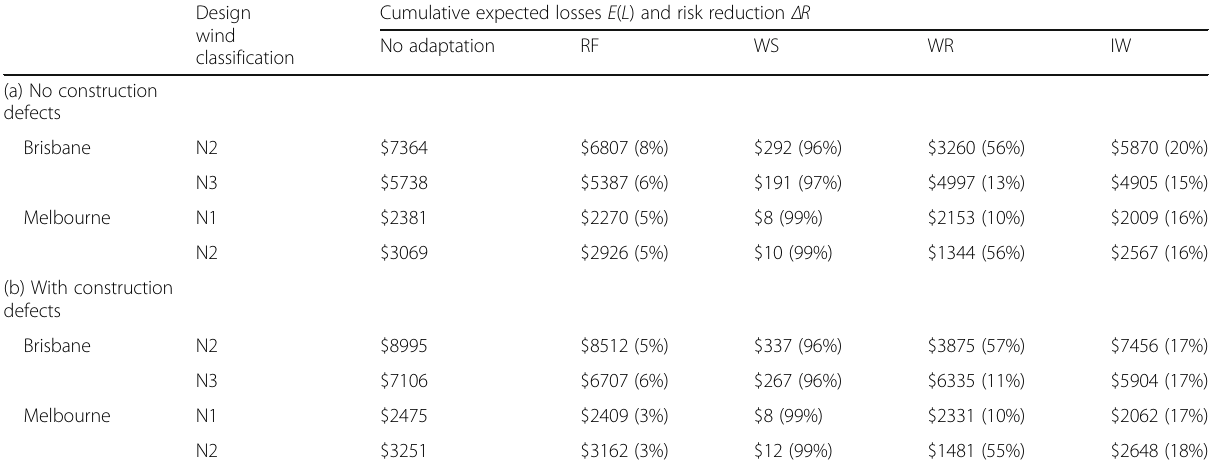
Table 7 Cumulative expected losses to 2070 with no climate change Design wind